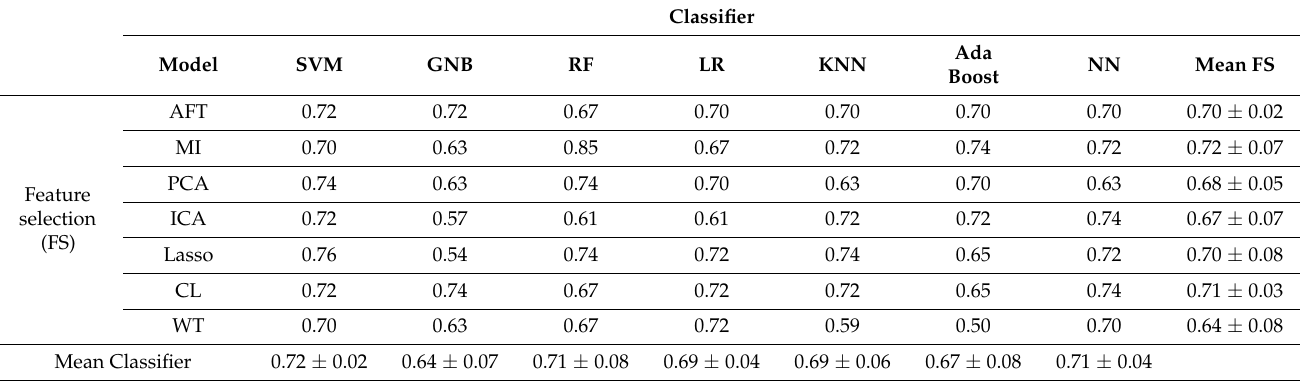
neighborhood, CL = clustering, AdaBoost = adaptive boosting. Table 7. Validation performance of all predictive models (FS + Classifier) in terms of the ACC. Values indicate the ACC of each model, or mean ACC ± one SD for a determined feature selection method or classifier. All models were evaluated on the validation